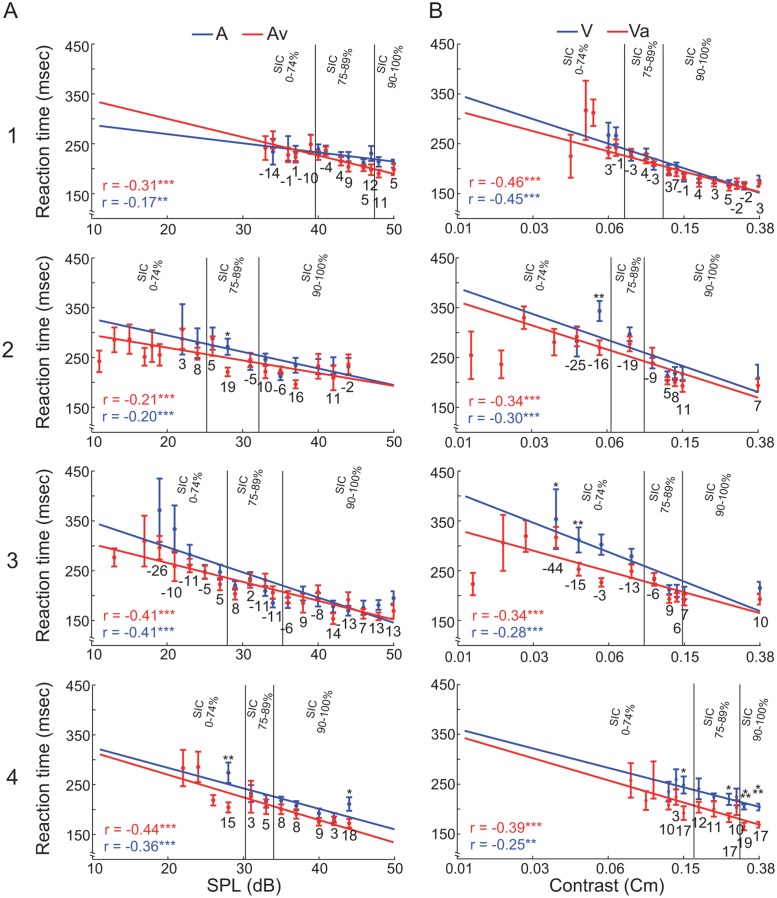
Reaction time data from the bimodal experiment.(A) Data for the stimulus conditions auditory-only (A) and auditory stimulation supported by a visual stimulus (Av). (B) Data for the stimulus conditions visual-only (V) and visual stimulation supported by an auditory stimulus (Va). Each row represents one ferret (1–4). RT ± SEM are shown as a function of stimulus amplitude (red = bimodal, blue = unimodal). Each data point represents the RT average for all hit trials recorded at that amplitude. Asterisks indicate significant differences between uni- and bimodal conditions (t-test: * = p < 0.05, ** = p < 0.01, *** = p < 0.001). Below each pair of uni- and bimodal RTs the Multisensory Response Enhancement (MRE) is shown as numerical values. In each panel, Pearson correlation coefficient and regression line for both data sets are shown. The two vertical lines mark the borders between the subject intensity classes (left of first line: 0–74%, between the lines 75–89%; right of the second line 90–100% performance).